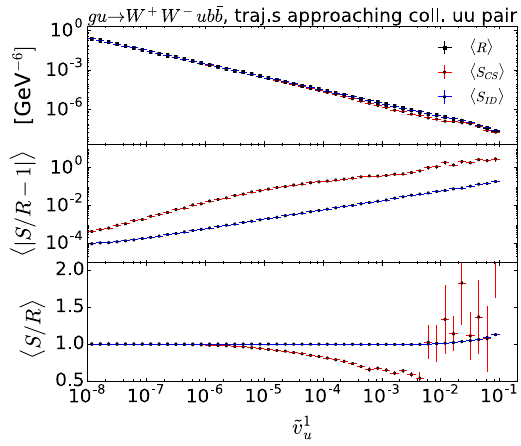
Fig. 9 Matrix elements R = | M R | 2 and sum of associated dipoles (cid:21) D (standard CS-dipoles in red, pseudo-dipoles in blue) for the S = process ug → W + W − ub ¯ b . Both dipole-types are evaluated on the same trajectories, with increasingly collinear partons, like described in